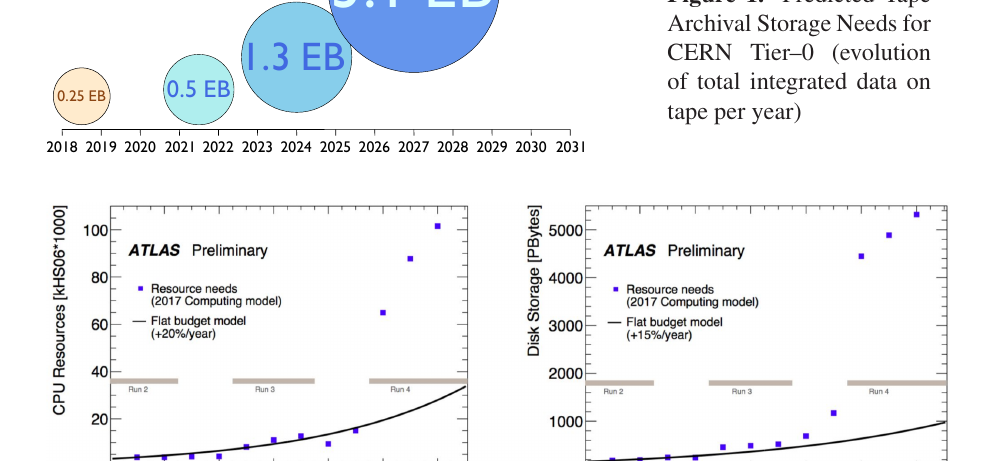
Figure 1. Predicted Tape